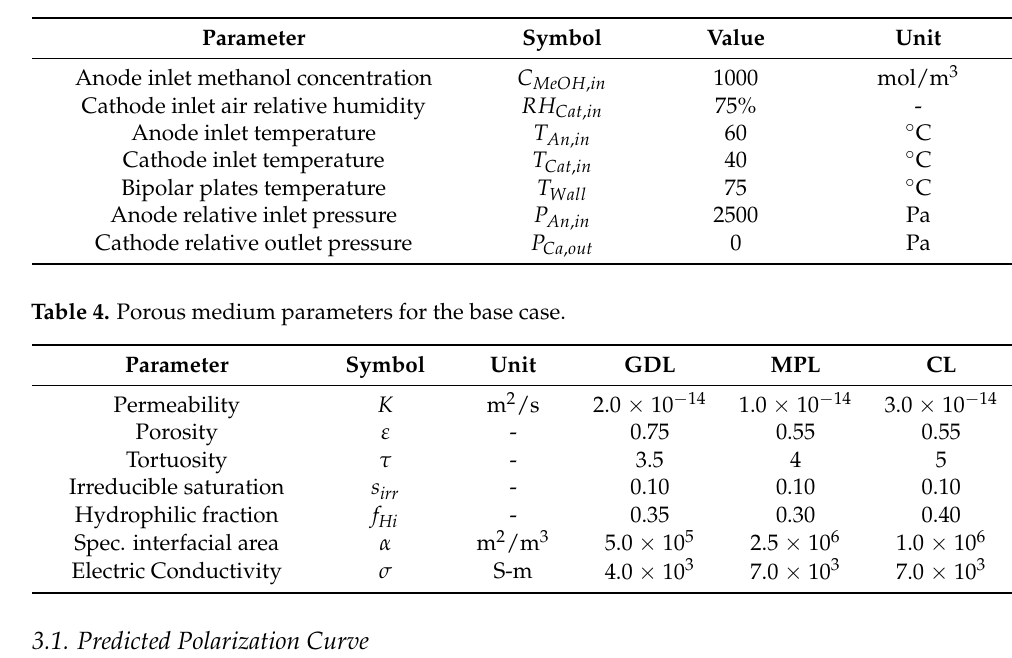
Table 3. Operating Conditions.